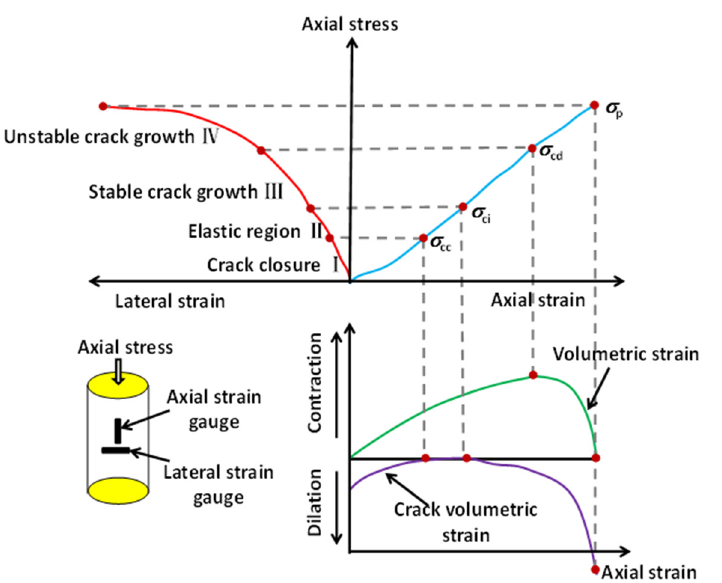
Figure 7. Schematic diagram of a rock stress–strain curve and corresponding stress threshold [29,40–